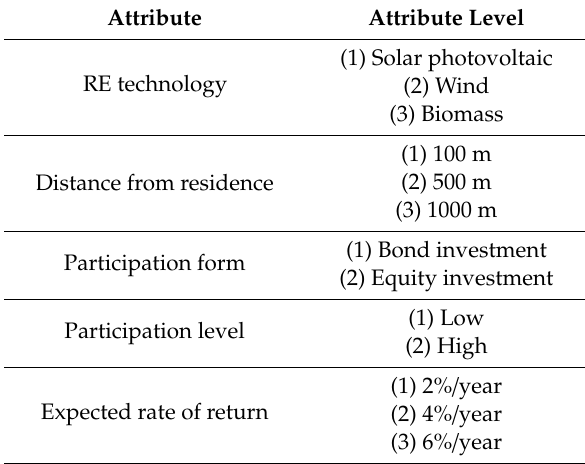
Table 1. Attributes of Renewable Energy (RE) projects for the choice experiment.